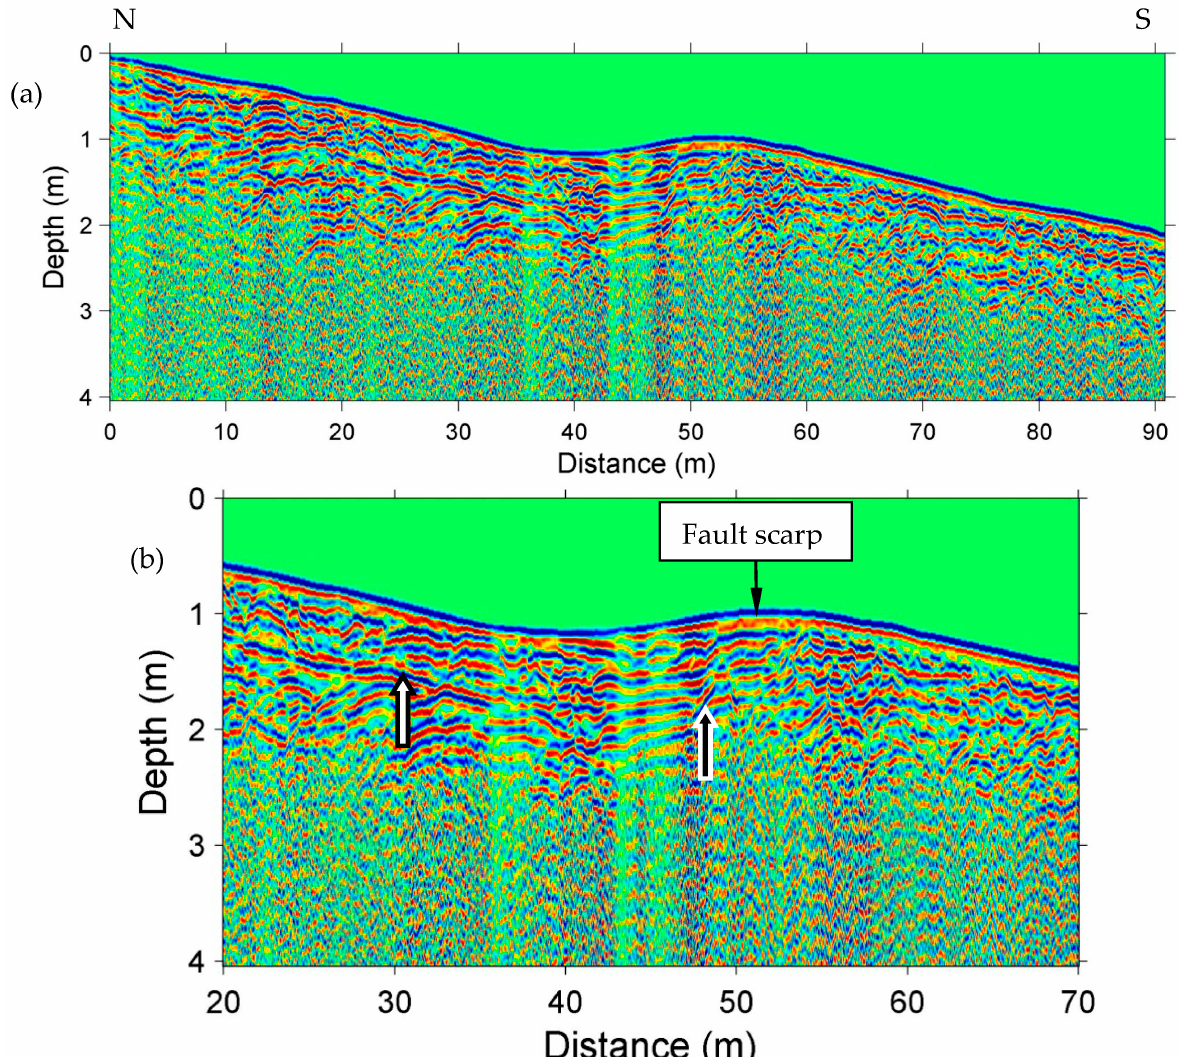
Figure 5. ( a ) GPR image of the profile at the southeastern part of the Songino fault (see red arrow of Figure 2 for the location) obtained with a 250 MHz antenna. The topographic corrections and depth conversion are performed using a velocity of 0.1 m/ns. ( b ) A zoom between 20 and 70 m horizontally is presented; black arrow indicates the fault zone. A change in GPR reflectivity is observed on both sides of the fault scarp at 52 m horizontally at the top of the smoothed fault scarp.